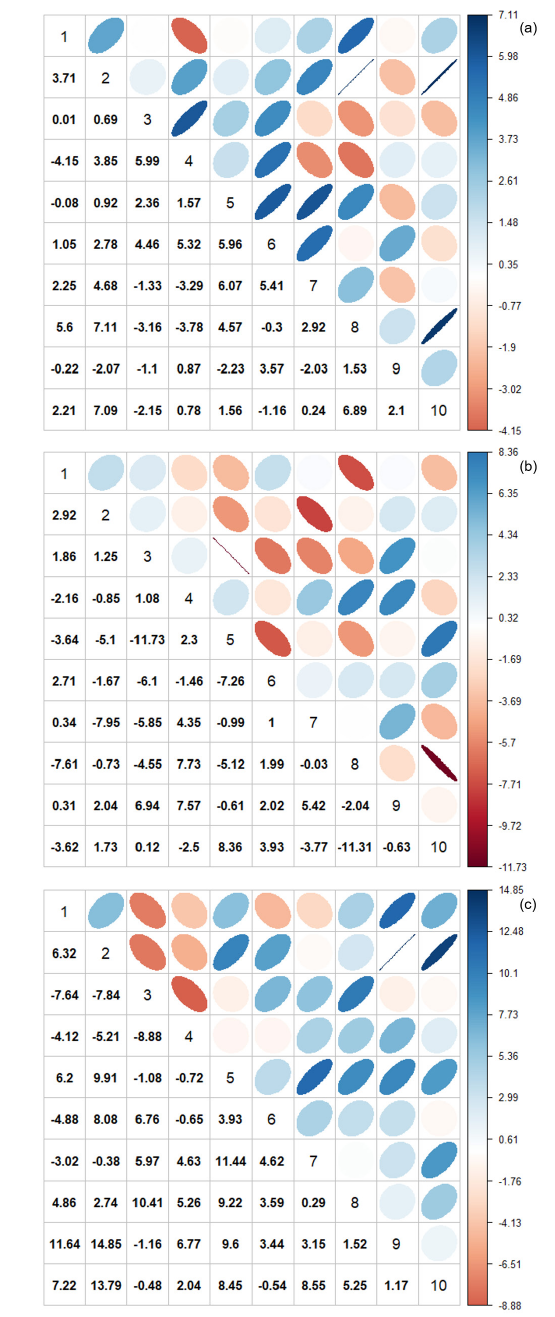
Figure 7. Reciprocal specific combining ability for mega-trait 3 (grain yield) of 90 crosses conducted inFrederico Westphalen (a), Pato Branco (b) and Campos Novos